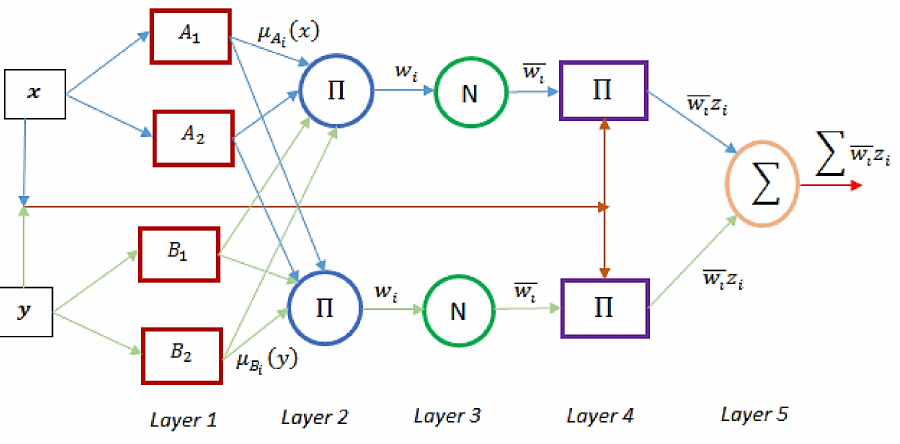
Figure 3. ANFIS structure